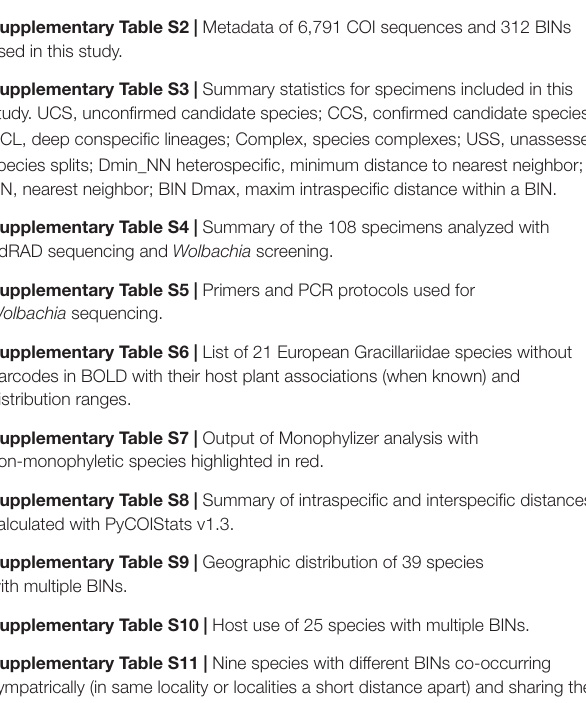
included in the checklist.